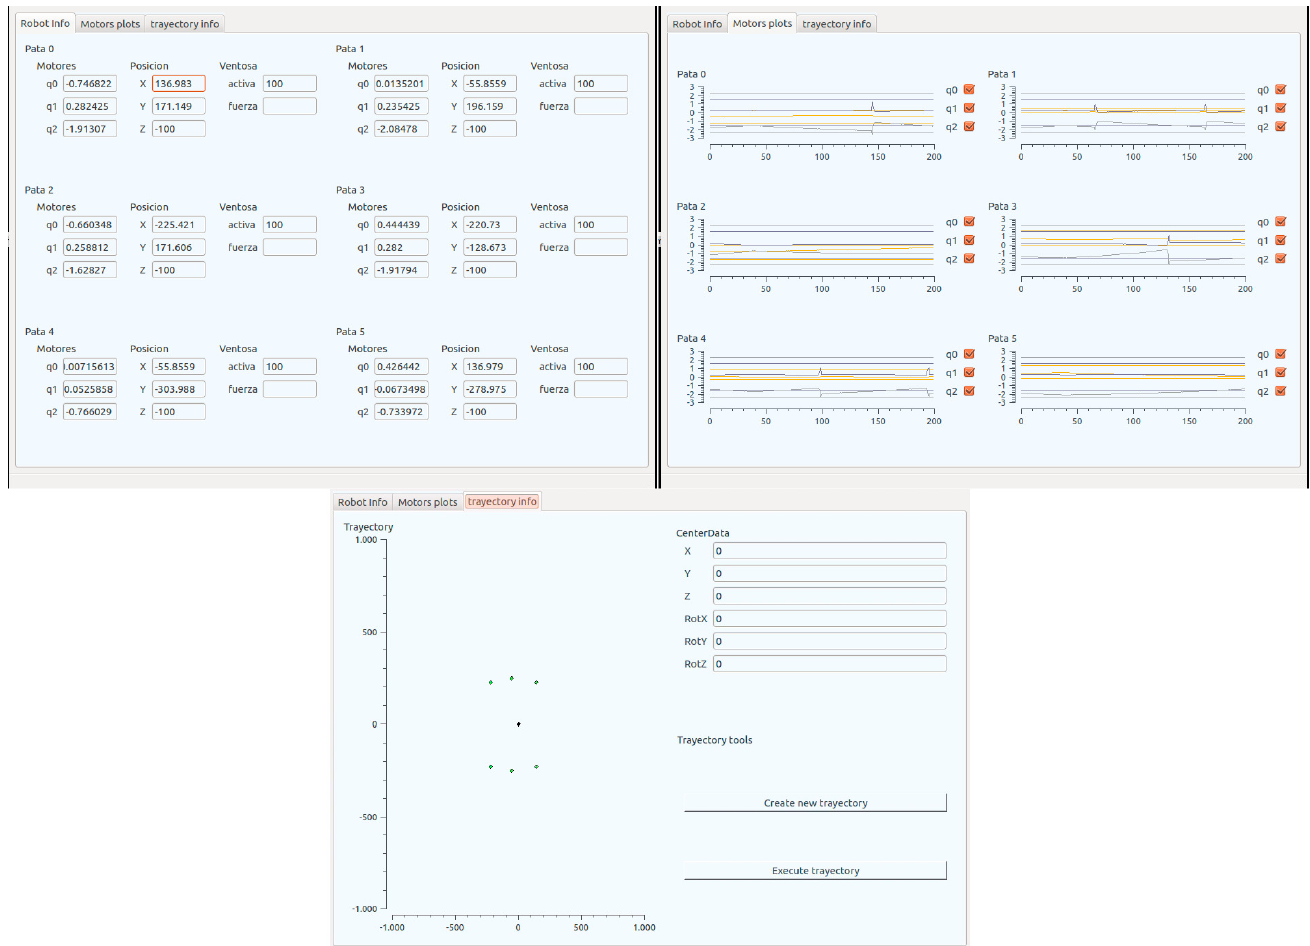
Figure 6. Graphical User Interface. The first tab shows information about the robot, including the motors and suction cup. The second tab shows the motors position during a given period. The third tab shows the whole robot trajectory, and it allows setting the goal position to execute a new